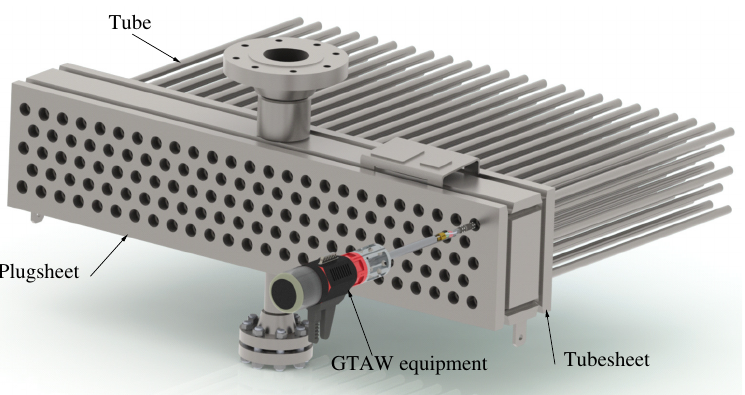
Figure 3. One header box of a heat exchanger with five rows of tubes and the orbital GTAW equipment positioned for operation.